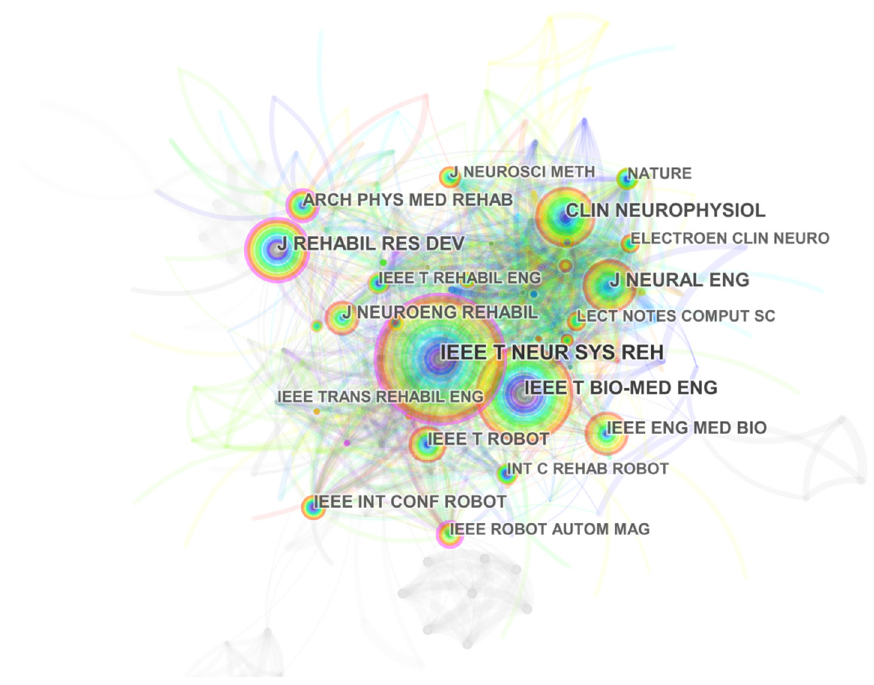
Figure 3. Journal co-citation map related to EPW HMI methodology research from 1998 to 2020. Table 2. Top five co-cited journals related to EPW HMI methodology research in terms of co-citation counts and centrality. Ranking Co-citation Count